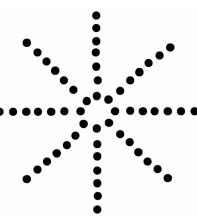
Figure 6. Antenna scatter plot.